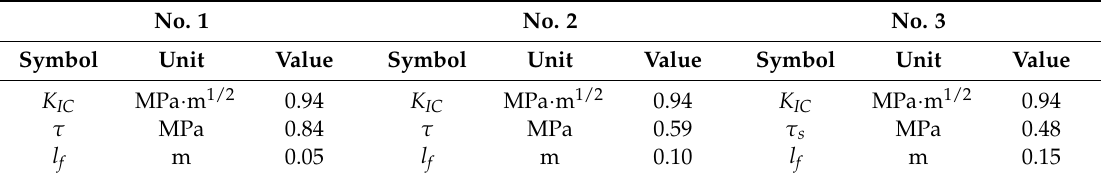
Table 2. T-type fracture model trial results.